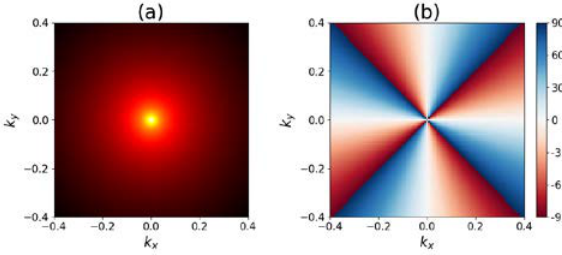
Fig. 1. (a) Q-factor and (b) phase of the polarization field in a PCS with hexagonal